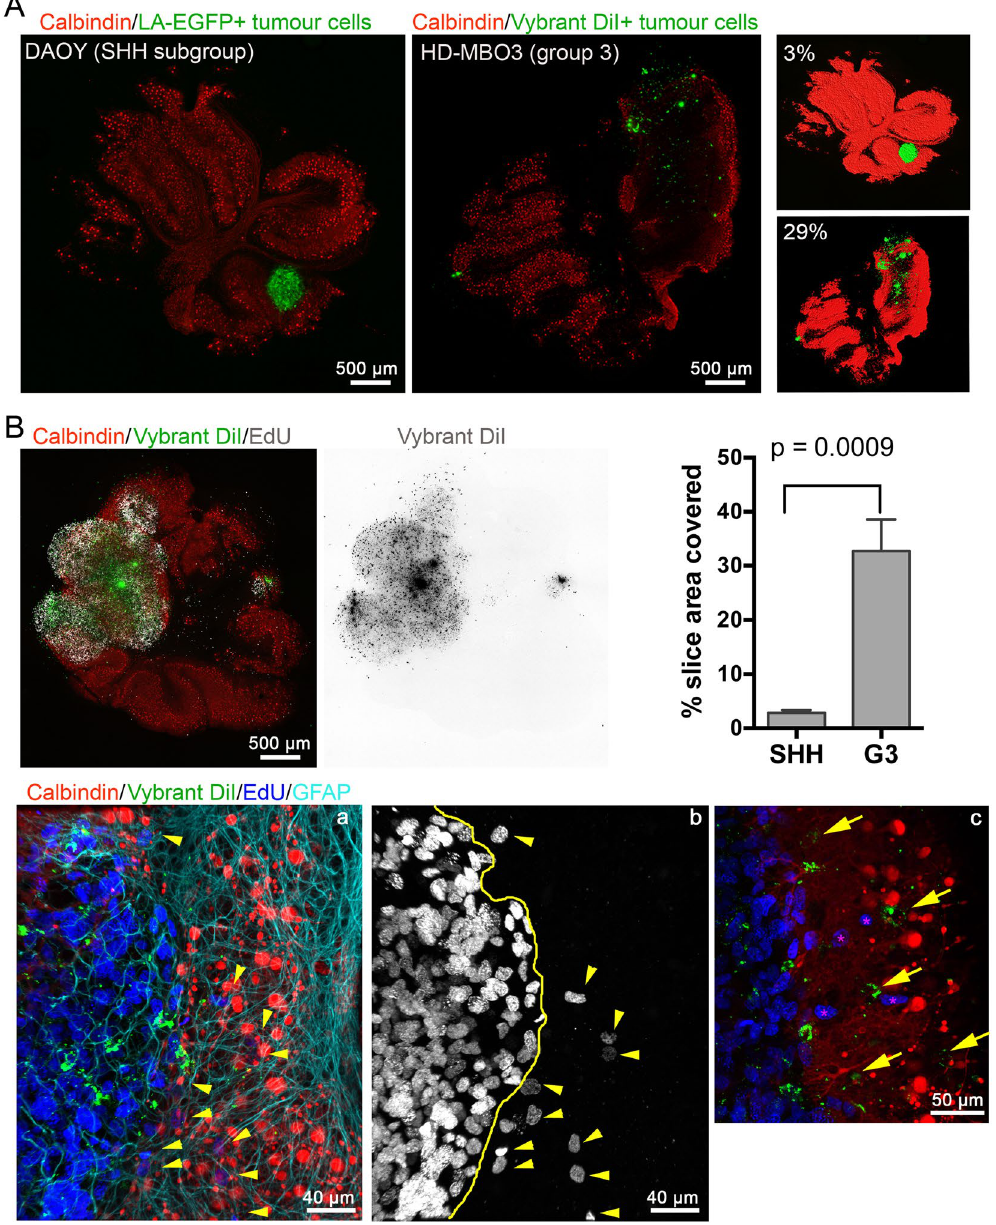
Figure 5. Massive growth and brain tissue infiltration of group 3 MB cells. ( A) LA-EGFP DAOY or HD- MBO3 cell spheroids were implanted in DIV 15 cerebellar slices and incubated for 5 days. Image show confocal microscopy image analysis of whole slices. Staining as indicated. Tumour area relative to whole cerebellar slice area was quantified (right panels) and was 2.9 and 29.0% for DAOY and HD-MBO3, respectively. ( B) Growth of HD-MBO3 spheroid in OCSC and microscopy analysis as in (A). Inverted grey scale images show Vybrant Dil staining of the tumour cells. Graphical representation of the occupancy obtained from three independent experiments for each cell line. Means and SD are shown with statistical analysis done using unpaired, two- tailed t-test. (a) is a higher magnification confocal image of the tumour-parenchyma border. Yellow line in (b) indicates tumour border and yellow arrowheads EdU-positive nuclei of infiltrating tumour cells. (c) as (a) but with yellow arrows pointing to EdU-negative infiltrating tumour cells identified by Vybrant Dil staining (green). Asterisks indicate EdU-positive nuclei of infiltrating tumour